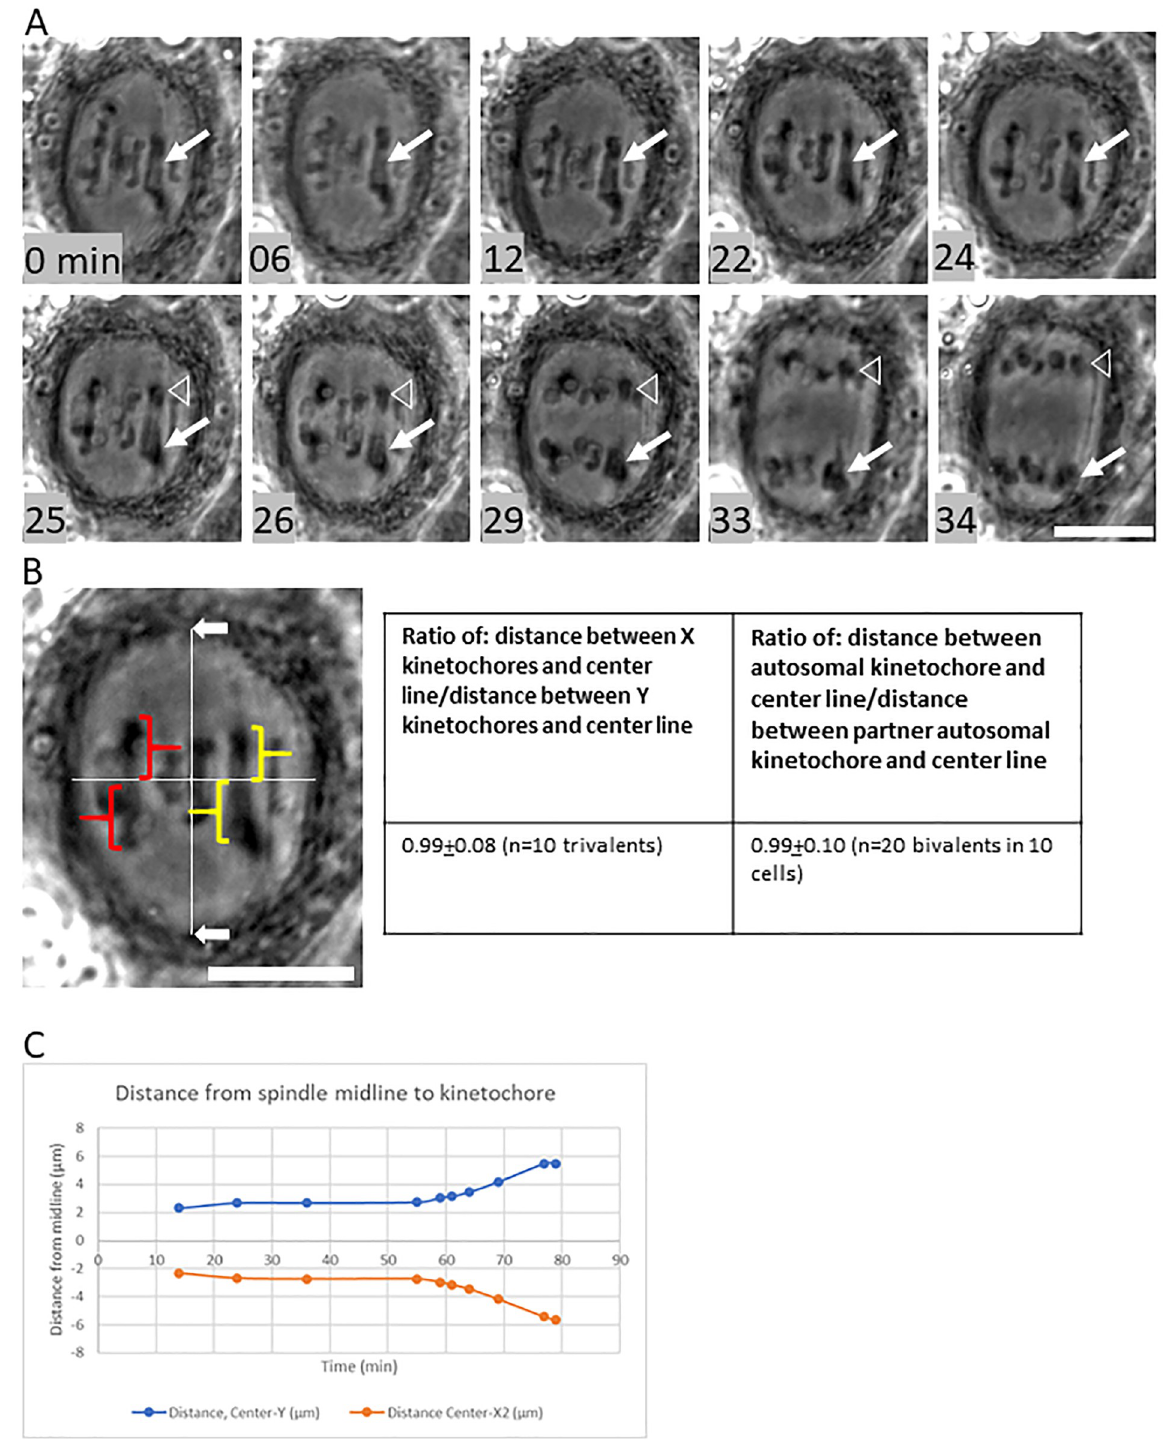
Fig 3. Segregation of chromosomes in meiosis I in the praying mantis Hierodula membranacea . A) Meiosis I spermatocyte with sex trivalent (arrow). The sex trivalent remains aligned on the metaphase plate with the autosomes (0, 6, 12, 22 min). Anaphase begins (24 min) and the Y chromosome (arrowhead) separates from the X 1 and X 2 chromosomes, which move together to the same spindle pole (arrow—26, 29, 33, 34 min). Scale bar = 10 μ m. B ) Analysis of the positioning of the trivalent and the autosomes at metaphase I. A line was drawn between the estimated spindle poles (white arrows), showing the spindle axis (left panel). A second line was drawn perpendicular to the spindle axis at the midpoint of